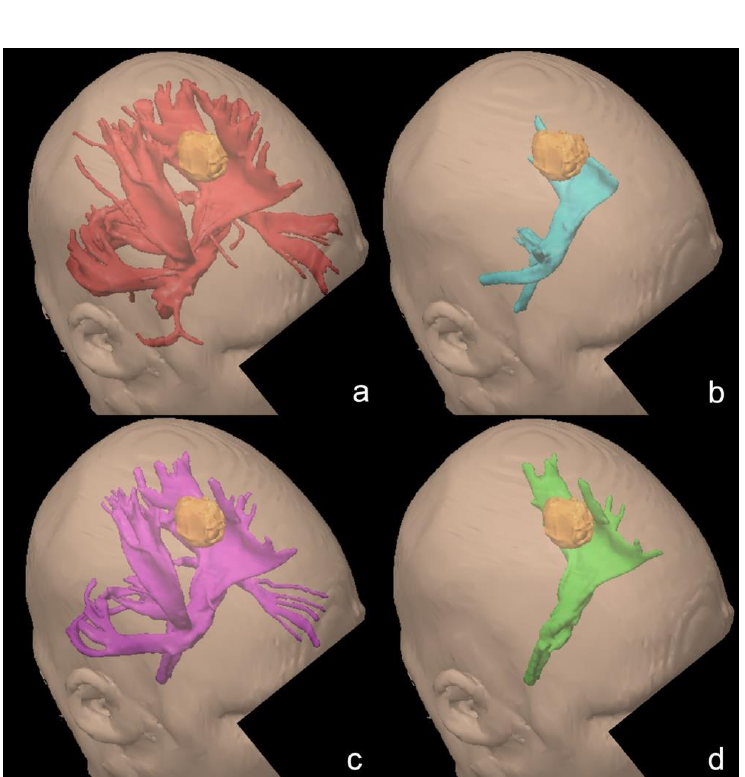
Figure 4. Illustrative case for tractography (iPlan Cranial 3.0, Brainlab AG, Munich, Germany) of an infiltrated CST in patient 11. For visualization, the streamlines have been rendered into volumes. Orange: tumor. ( a ): Tractography with the FA cutoff set to 0.1 (red). Many collaterals are included. ( b ): Tractography with the FA cutoff set to 0.3 (blue). In proximity to the cortex, the tractogram is cut off early. ( c ): Tractography with the FA cutoff set to 0.15 (purple). Collaterals to the cerebellum, the contralateral hemisphere, and the inferior fronto-occipital fascicle are included. ( d ): After exclusion of collaterals from the tractogram (4c, purple), an anatomically realistic tractogram remains (green). Infiltration of the CST is evident in all tractograms.